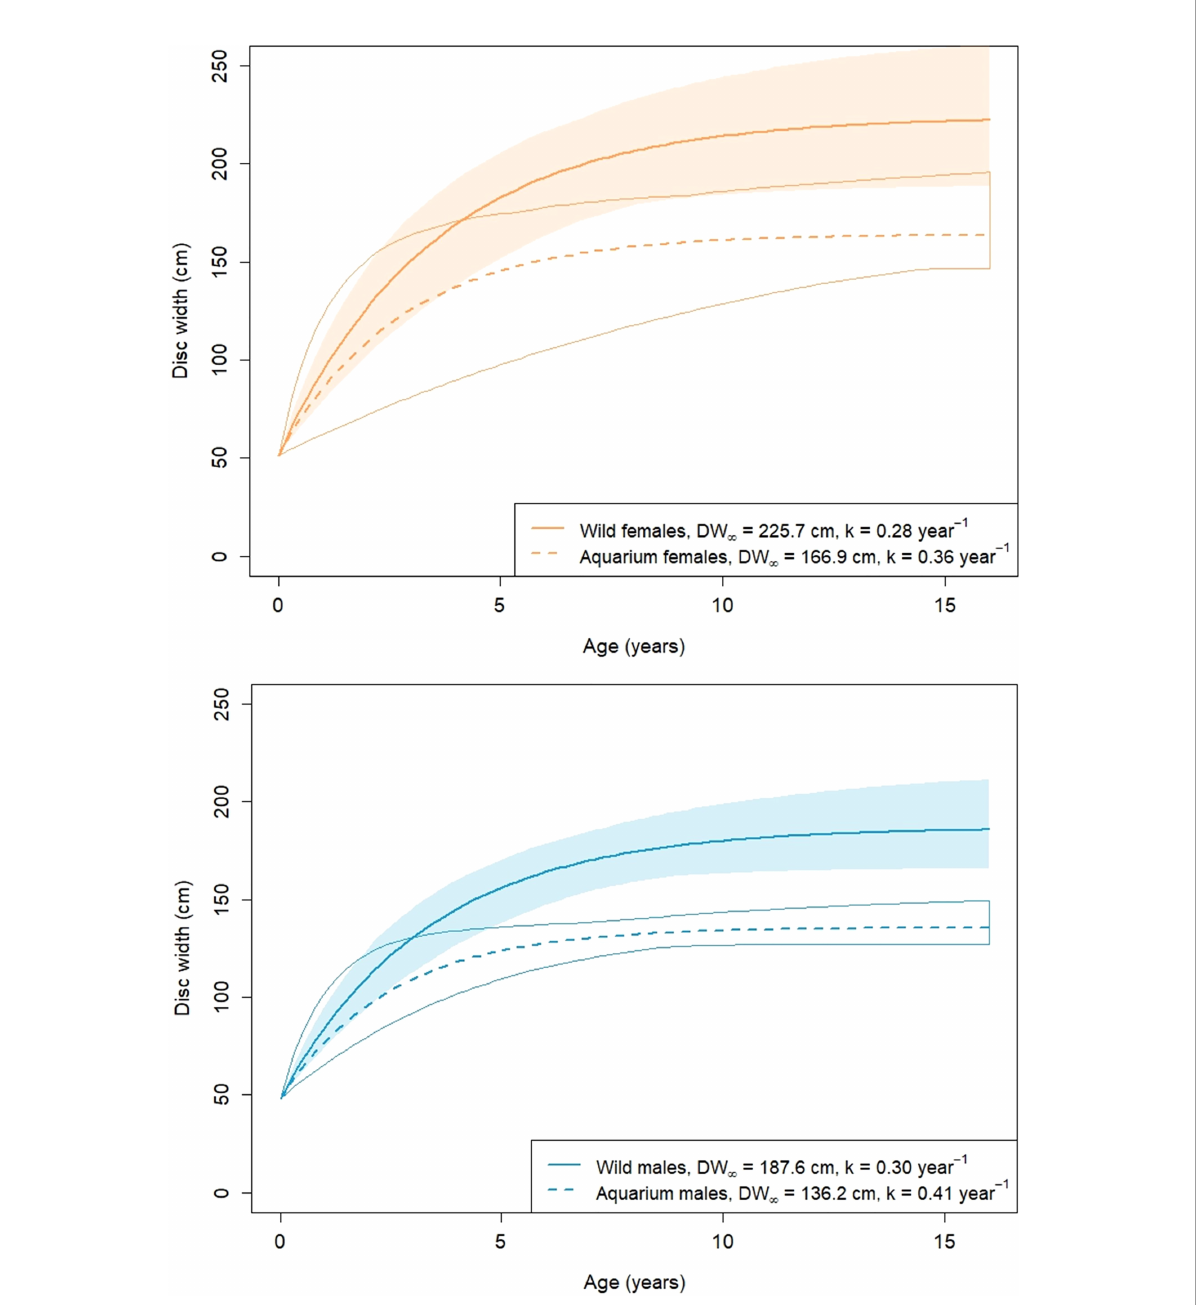
FIGURE 4 A. narinari von Bertalanffy growth curves inferred from Bayesian estimates (posterior medians). The envelope around each curve represents 95% credible intervals from posterior